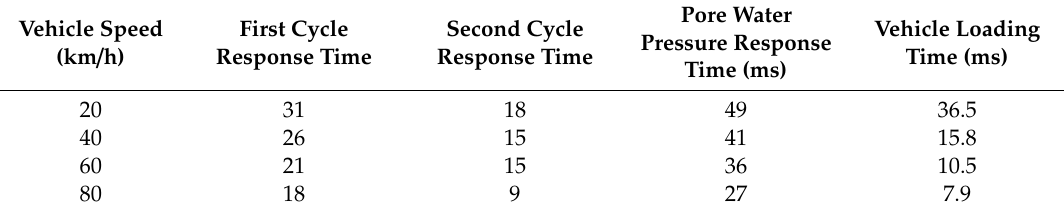
Table 6. The relationship between pore water pressure response time and vehicle speed.